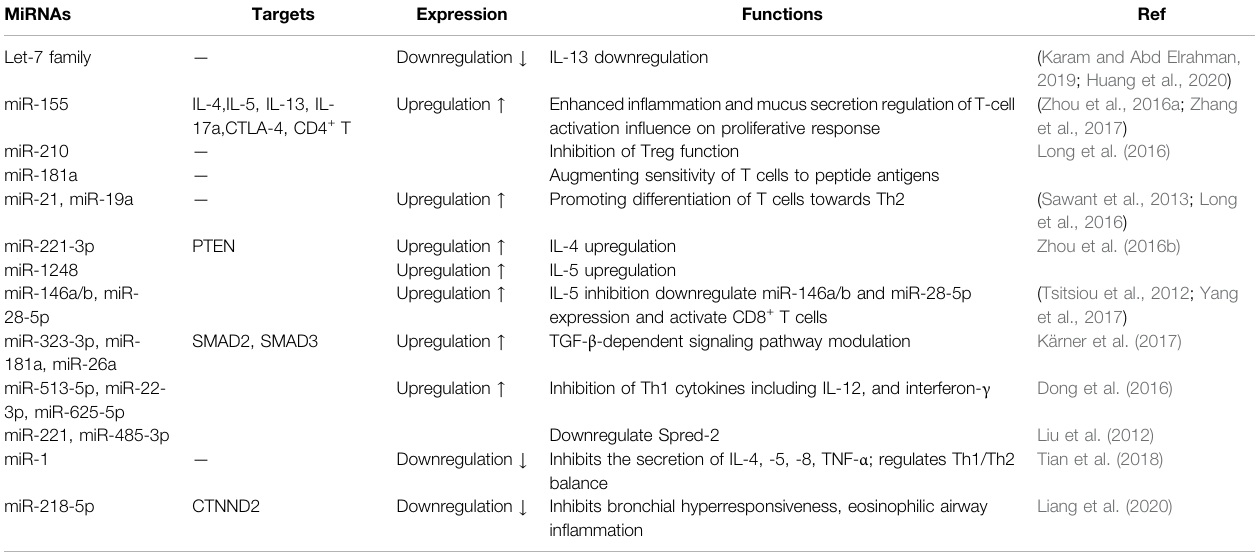
TABLE 3 | Roles of selected miRNAs in childhood asthma.